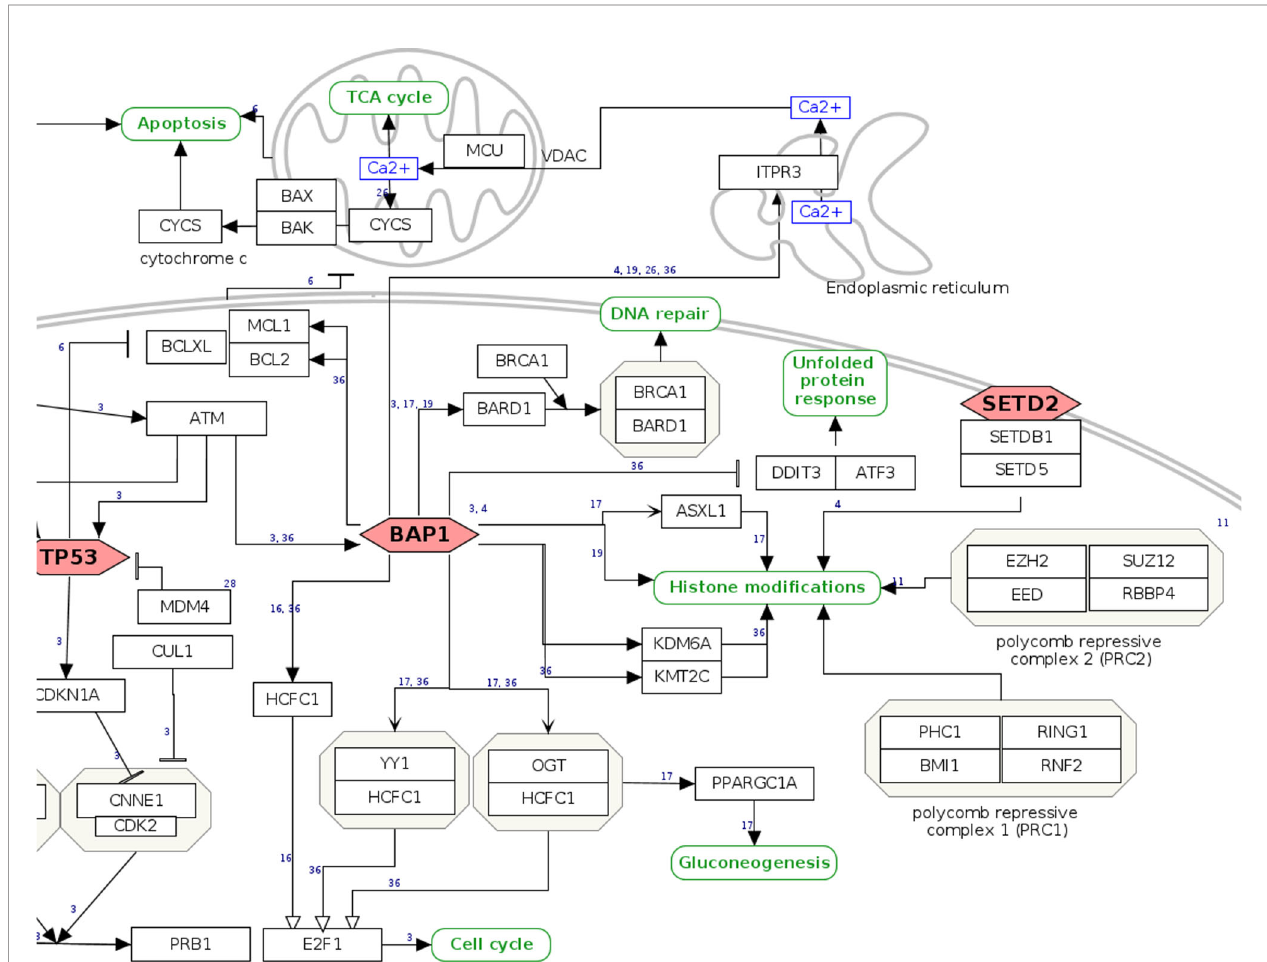
FIGURE 2 | BAP1 pathway section. Genes and proteins are visualized as black rectangles, and frequently mutated tumor-suppressor genes are drawn as red diamonds. Green rounded rectangles are links to other pathway entries in the WikiPathways